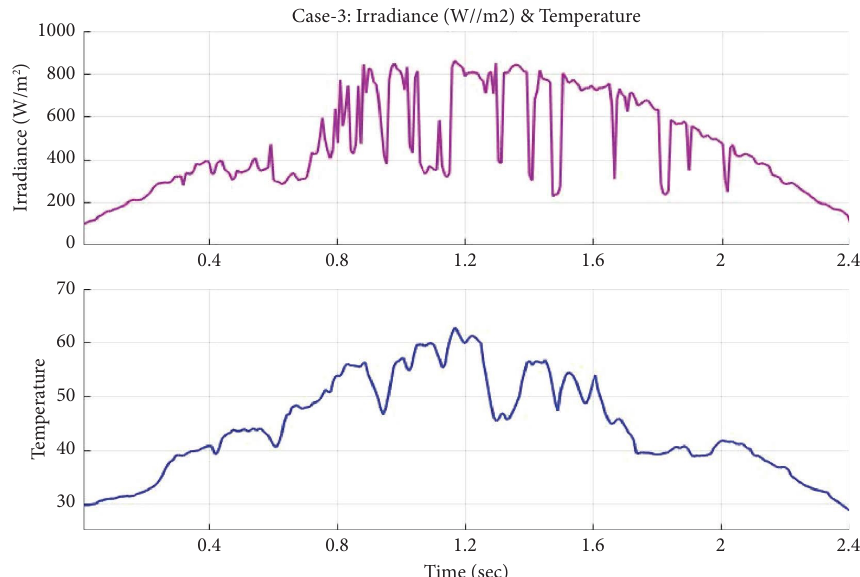
Figure 21: Real-time solar irradiation and temperature data.